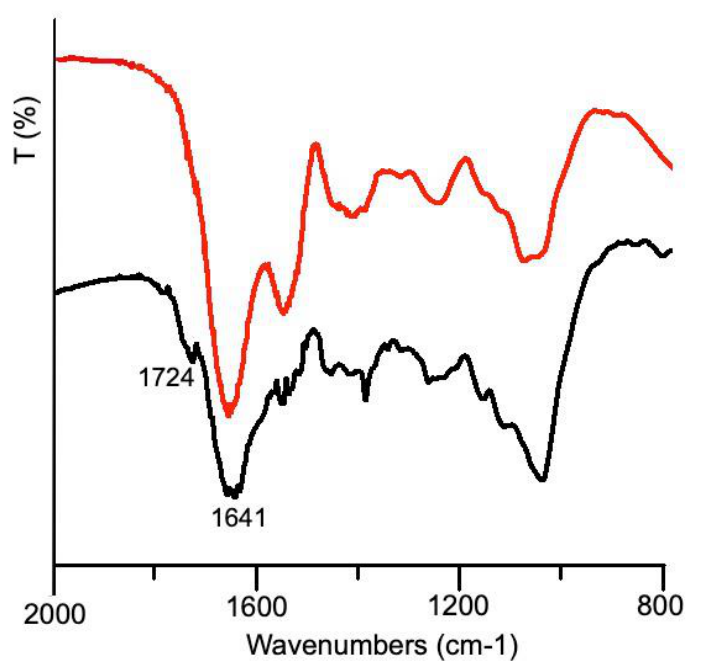
Figure 5. Infrared spectra of dialyzed snail slime (red line) and dried AgNPs collected from synthesis H.